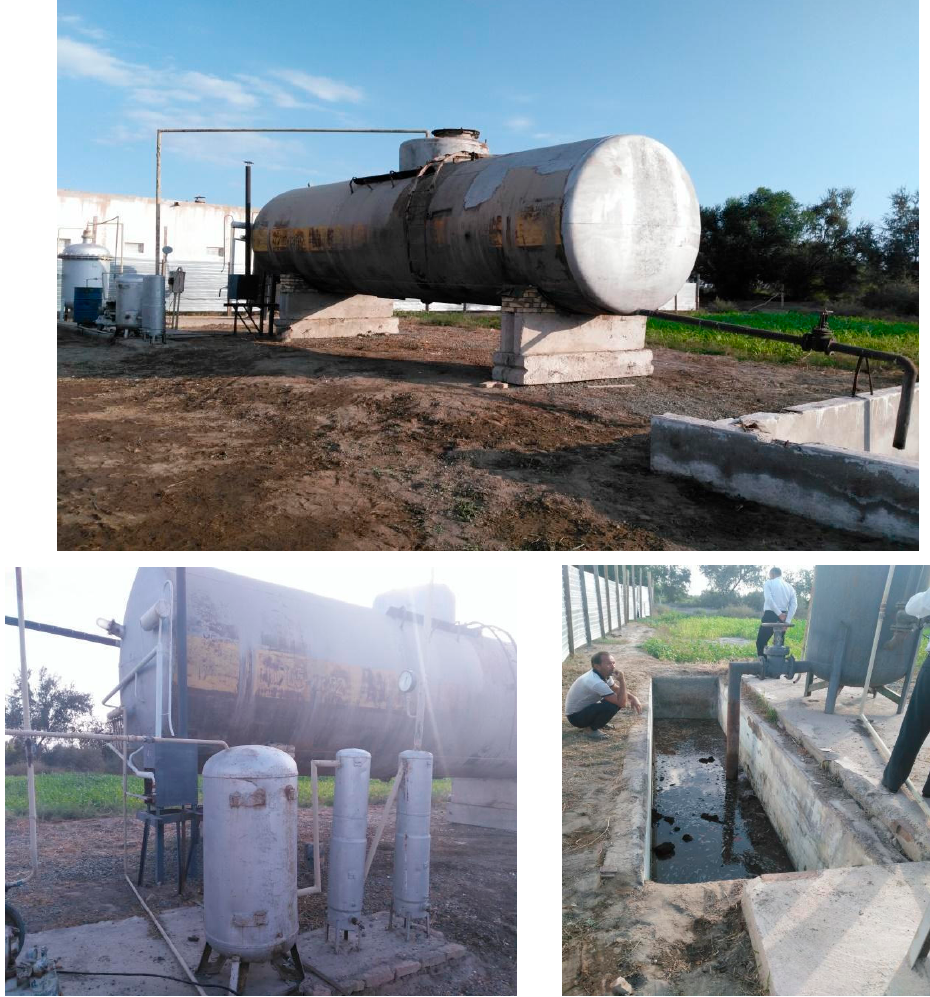
Figure 4. Biogas plant at Biougit Limited Liability Company (LLC).